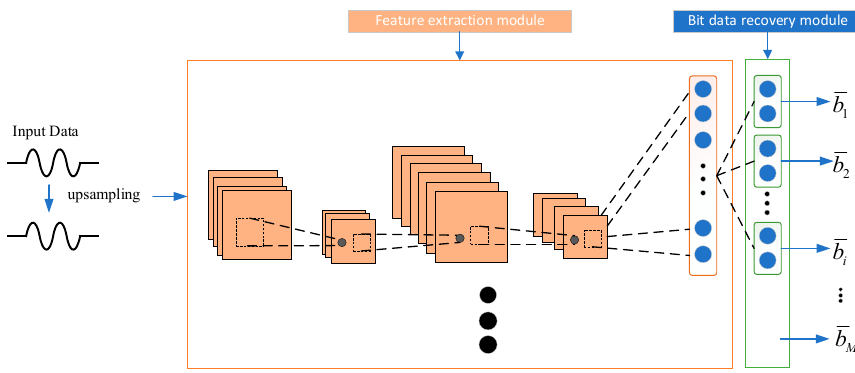
Figure 4. Principle of intelligent receiver model.